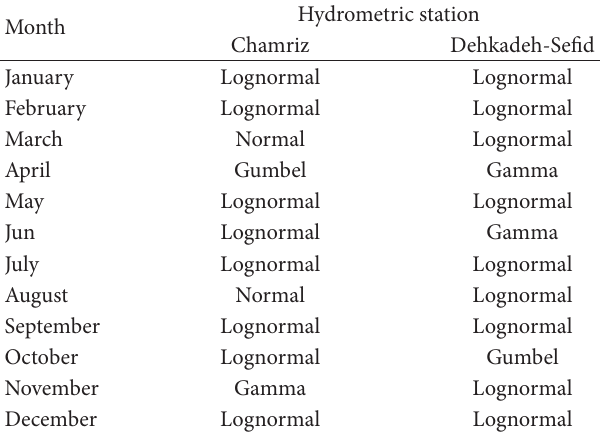
Table 1: Best fitting distribution function for each month at two